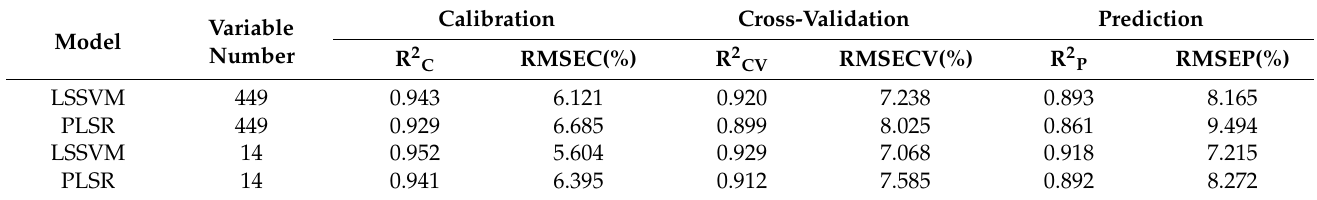
Figure 5. ( a ) RMSECV plot for identifying the optimum γ and 1/ σ 2 in LSSVM model, ( b ) The changing trend of RMSECV with the increase of LVs in PLSR model. Table 2. Performance of models for predicting S-ovalbumin content in eggs.